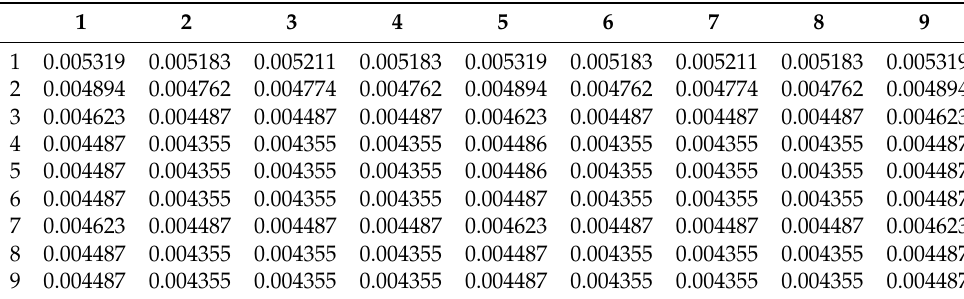
Table 2. Power value (Watts) of each aperture (Y axis, δ = − 2 ◦